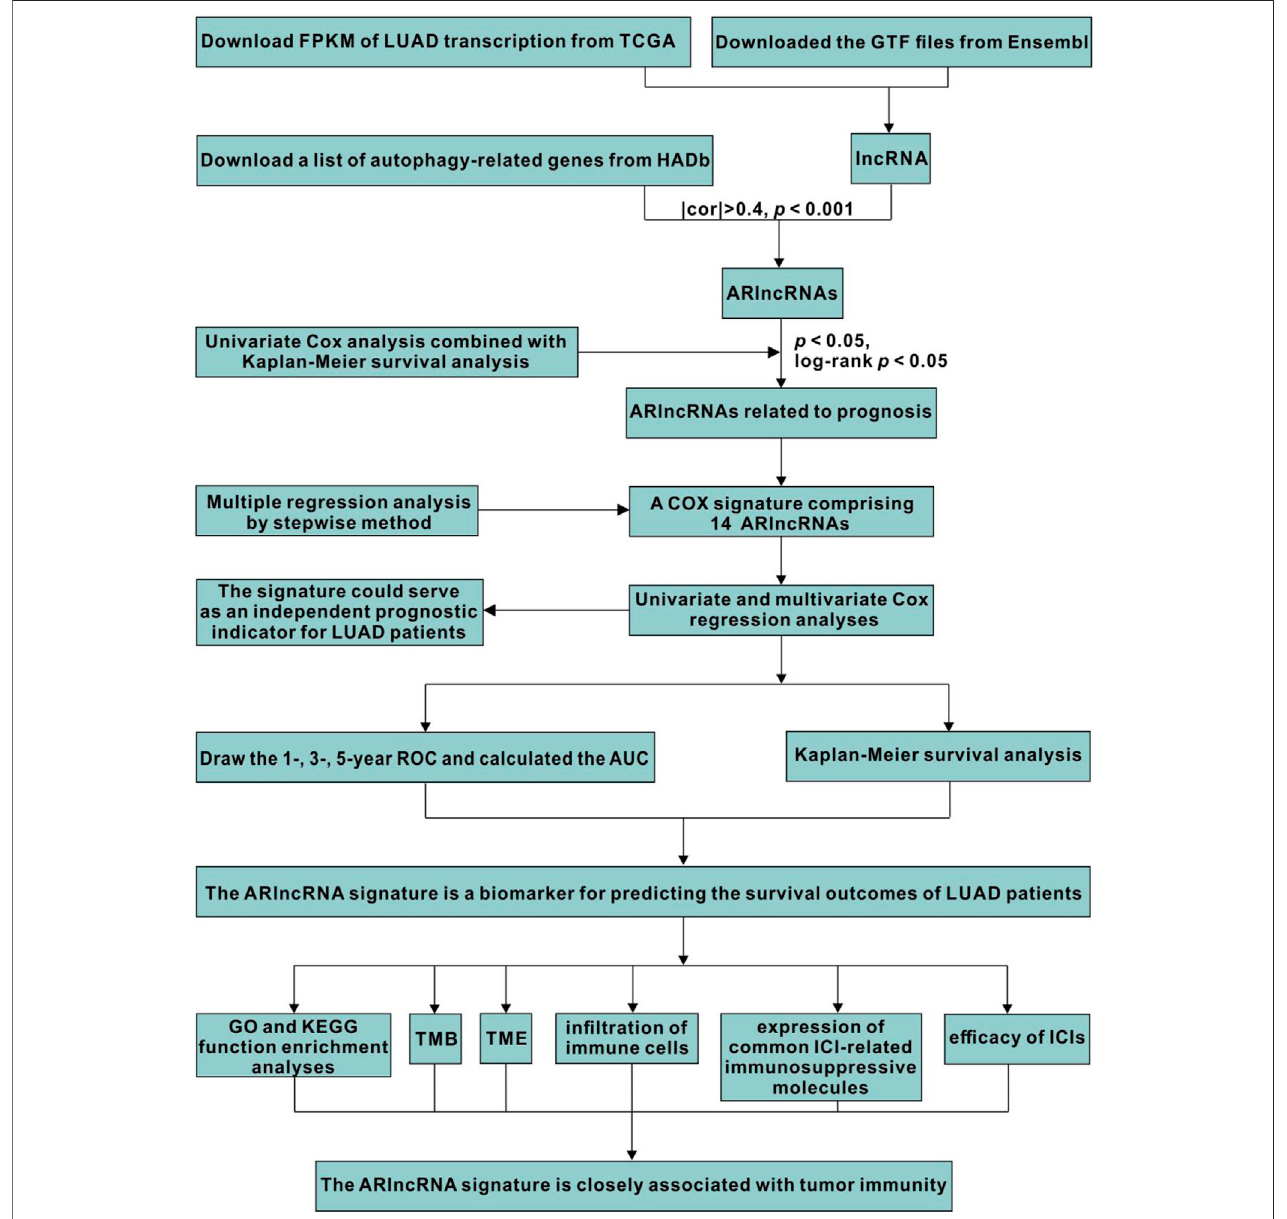
FIGURE 1 | The fl owchart for identifying a novel reliable ARlncRNA signature and its